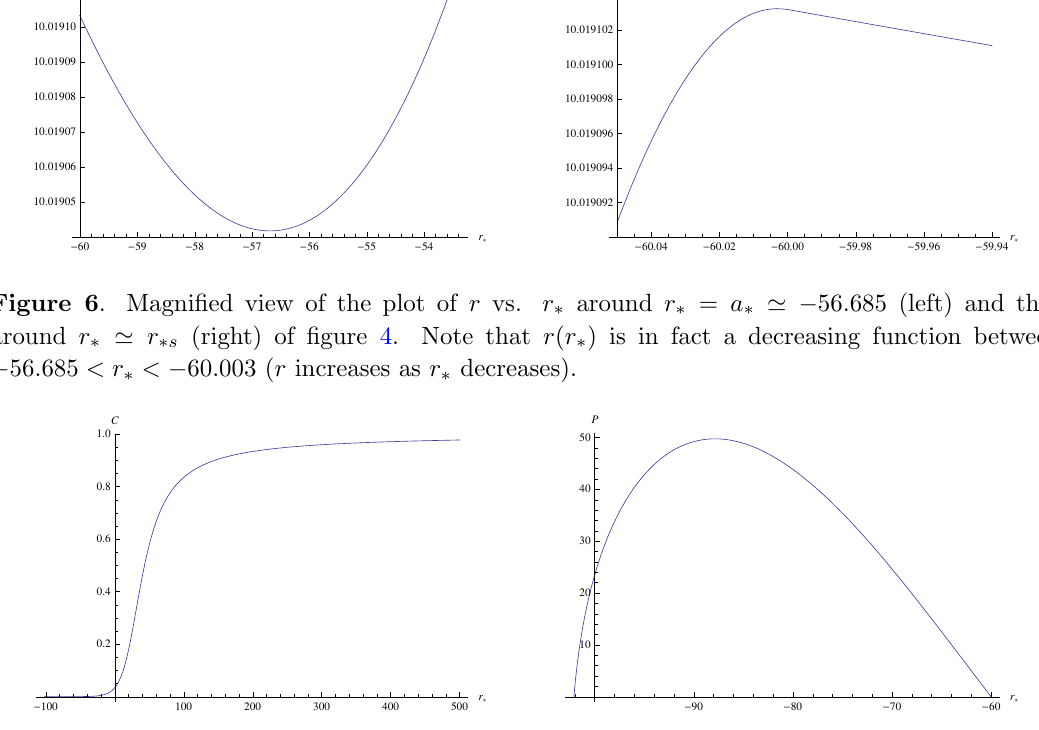
Figure 7 . The factor C and pressure P for (cid:20)m 0 = 50, r (cid:3) s = (cid:0) 60 < a (cid:3) , a 0 = 10 and (cid:11) = 0 : 05. On the left: the factor C is always positive and non-zero. On the right: the pressure P is zero at both the outer surface r (cid:3) = (cid:0) 60, and the inner surface r (cid:3) ’ (cid:0) 102 : 086, and it is positive in